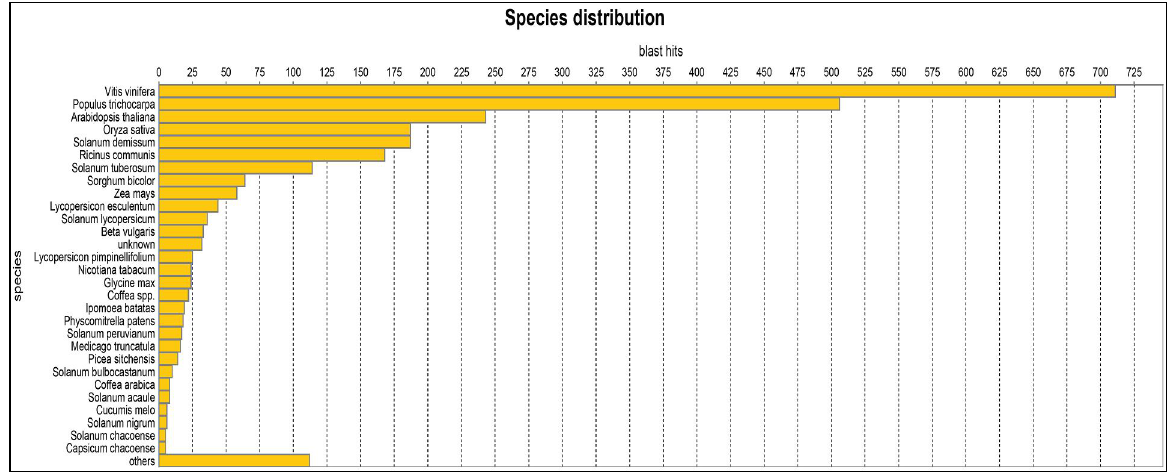
Figure S2 : Species with most blast hits with the